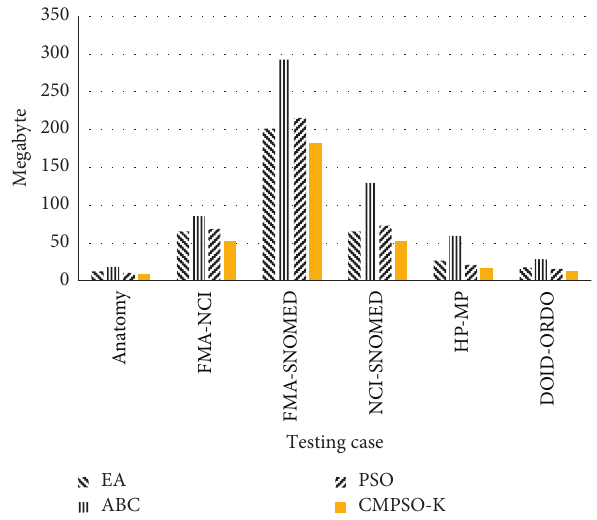
Figure 5: Comparison on the memory